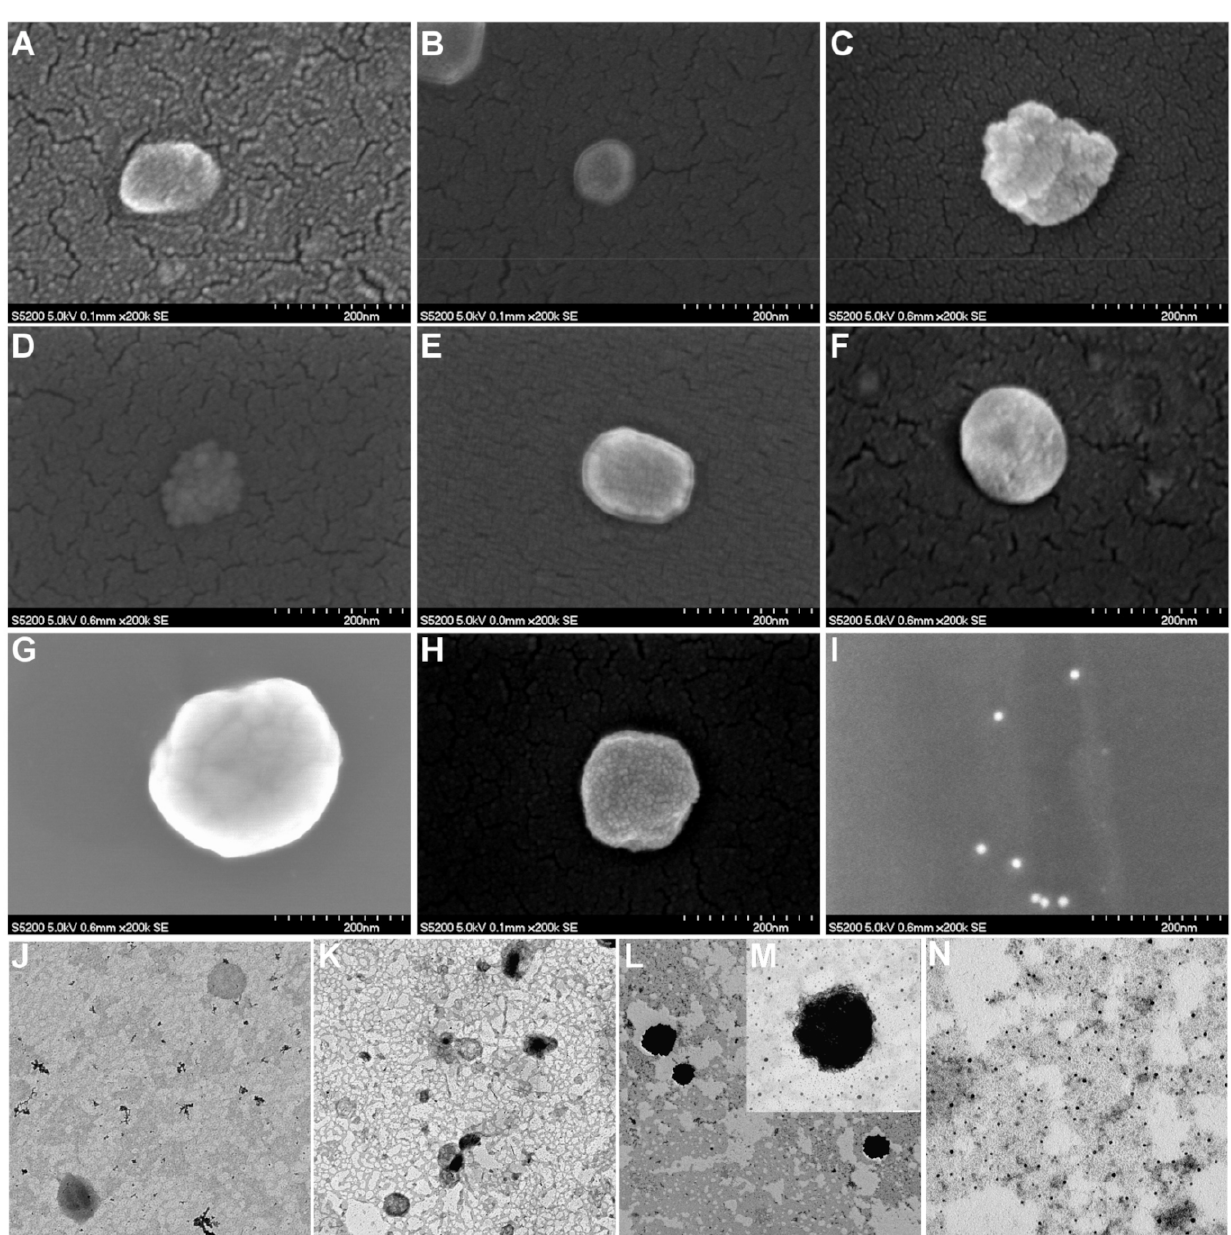
Figure 5. FE-SEM images of ( A ) L1, ( B ) L2, ( C ) AuNPs-L1, ( D ) AuNPs-L2, ( E ) L1-D, ( F ) L2-D, ( G ) AuNPs-L1-D, ( H ) AuNPs- L2-D, and ( I ) AuNPs (scale bar: 200 nm). TEM images of ( J ) L2 (scale bar: 0.5 µ m), ( K ) L2-D (scale bar: 1 µ m), ( L , M ) AuNPs-L2-D (scale bar: 0.5 and 0.1 µ m, respectively) and ( N ) AuNPs (scale bar: 0.1 µ m). L1 and L2: liposomes with different proportions of cholesterol, 3.35 mol% y 40 mol%, respectively; AuNPs: gold nanoparticles (15 nm), and D: